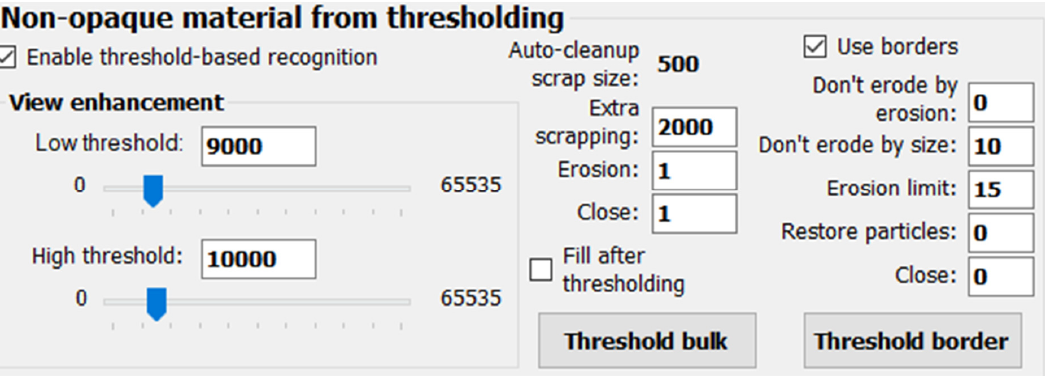
Figure 12. Threshold ‐ based identification frame with the “Use borders” section enabled.